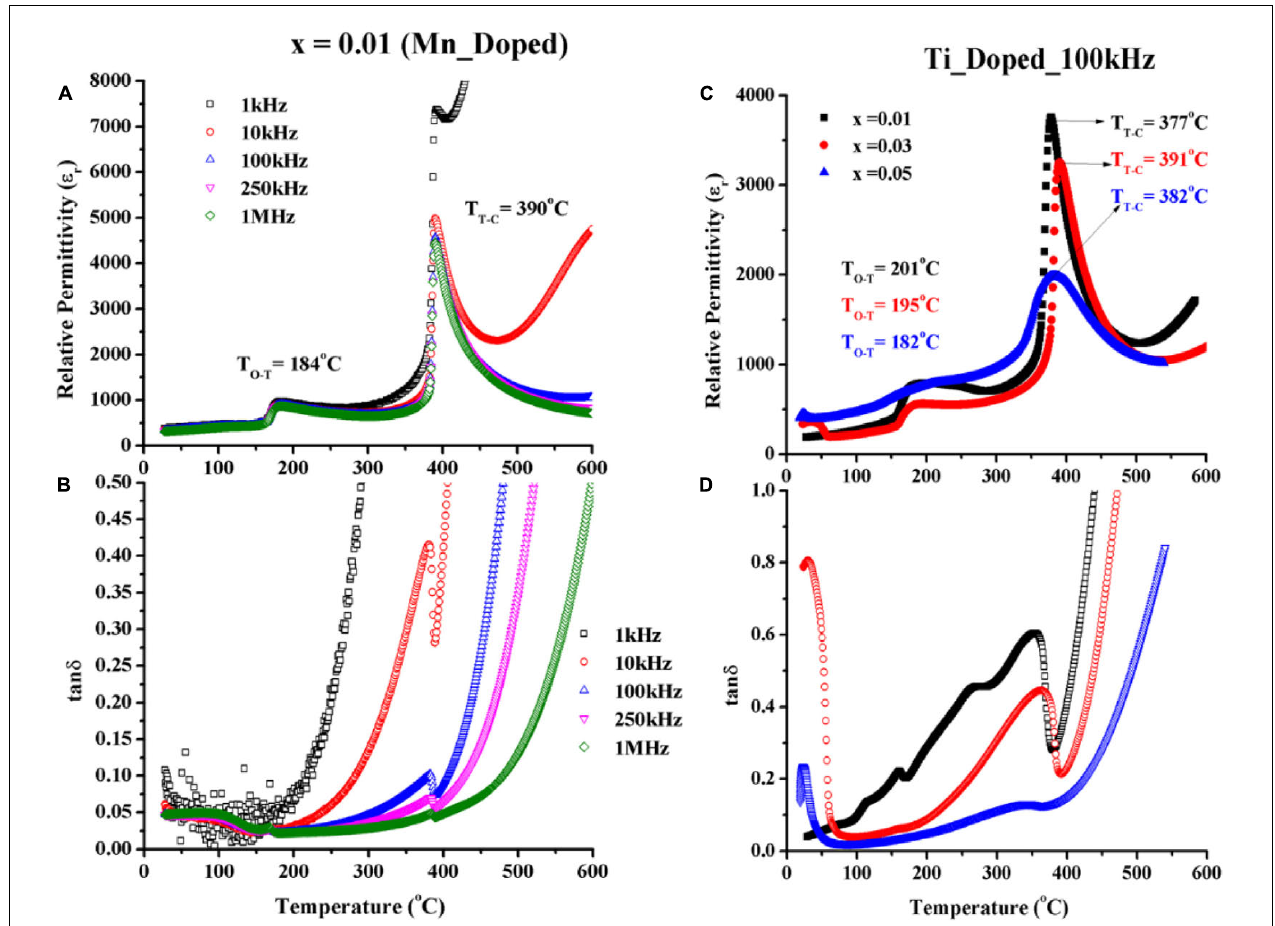
FIGURE 5 | (A) ε r and (B) tan δ versus temperature of Mn-doped KNN; (C) ε r and (D) tan δ versus temperature of Ti-doped KNN compositions.